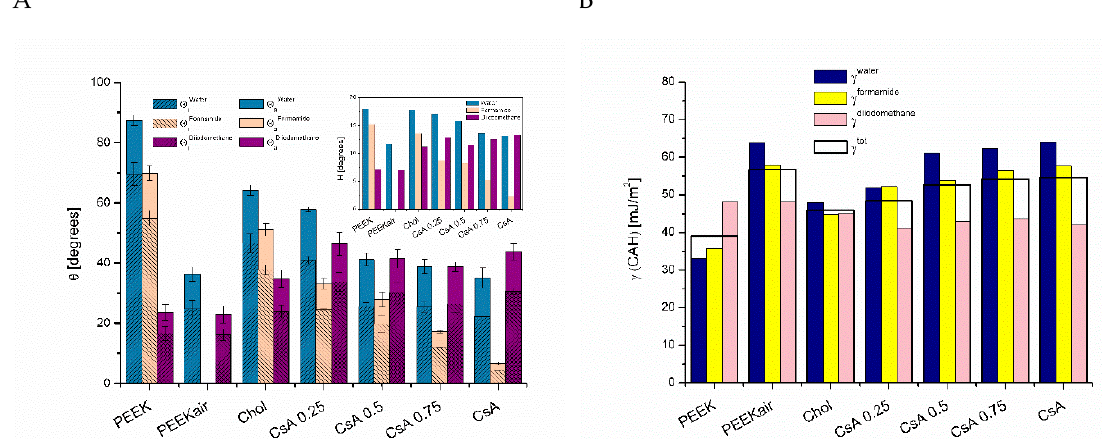
Figure 5. ( A )—Advancing and receding contact angles of water, formamide and diiodomethane and their hysteresis (H); ( B )—Surface free energy γ s estimated from the contact angle hysteresis of water, formamide, and diiodomethane and their arithmetic mean ( γ tot s ) for the modified PEEK surfaces.